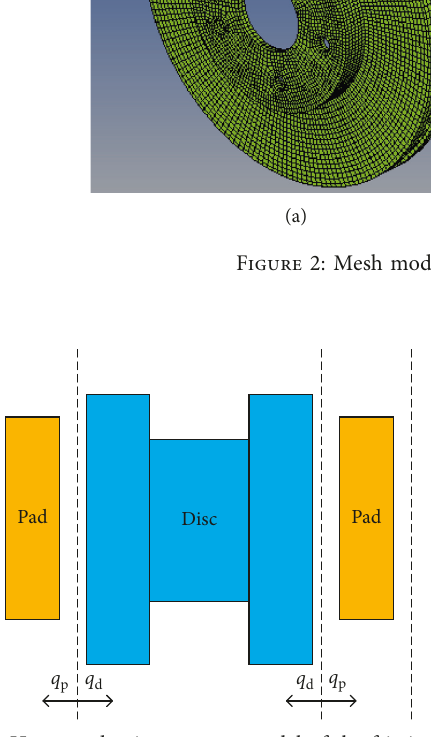
Figure 3: Heat conduction contact model of the friction pair.